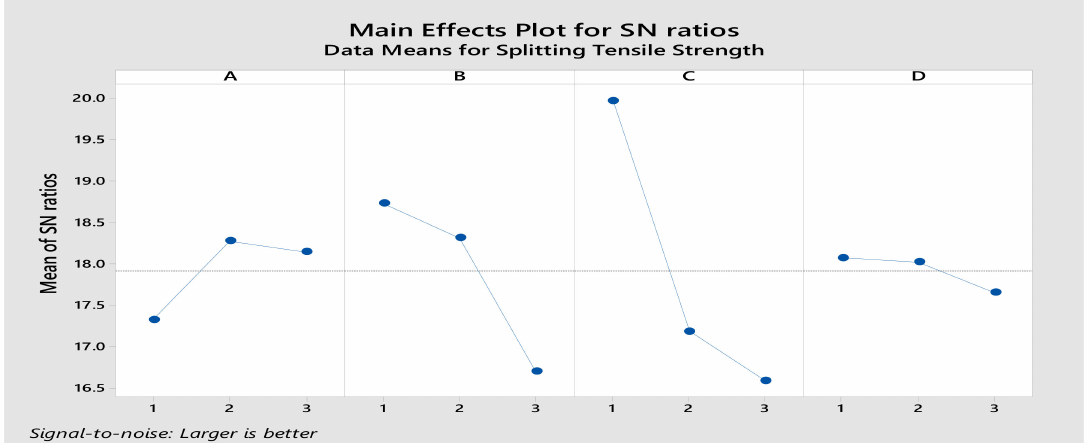
Figure 6. Main effects plot of SN ratios for splitting tensile strength using the Taguchi method.